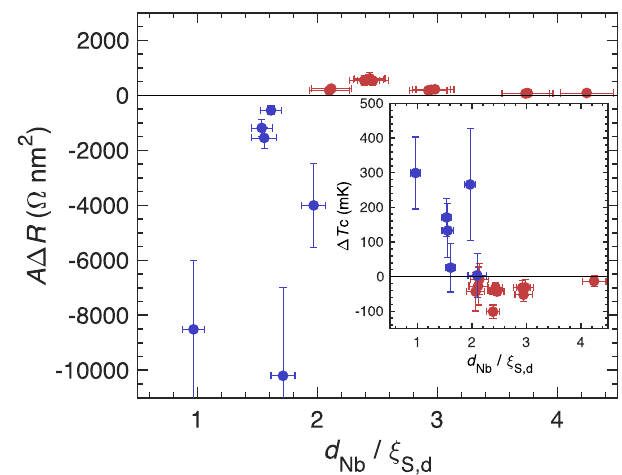
Fig. 3 Spin decay in the normal and superconducting states. A ∣ Δ R ∣ (device area A , magnetoresistance Δ R ) vs. Nb thickness ( d Nb ) in current perpendicular-to-plane spin valves for both the normal state (below 10 K, grey) and superconducting state ( T / T device = 0.3, red/blue, where T is temperature and T device is the onset temperature of the device transition). Red circles are devices showing quasiparticle giant magnetoresistance, whereas blue circles show the superconducting spin valve effect. For clarity, points are the mean value from multiple devices on a single substrate; vertical error bars are the standard deviation in A Δ R of these devices and horizontal error bars the uncertainty in d Nb . Supplementary Fig. 3 features this plot with devices plotted as individual points. Fits are a simple exponential decay considering each device individually, as described in the Normal state spin decay section.